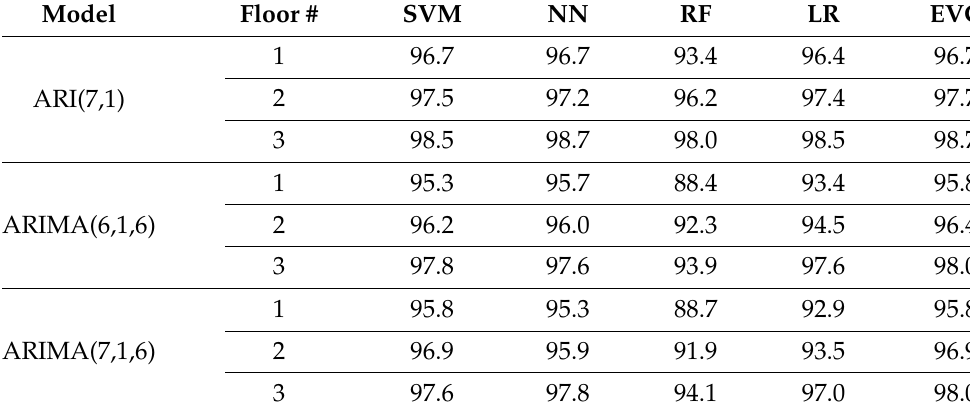
Table 6. Accuracy (%) of the local damage detection for different candidate models.